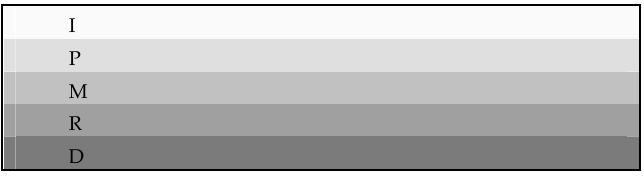
Figure 1. Moves and corresponding gray tones .